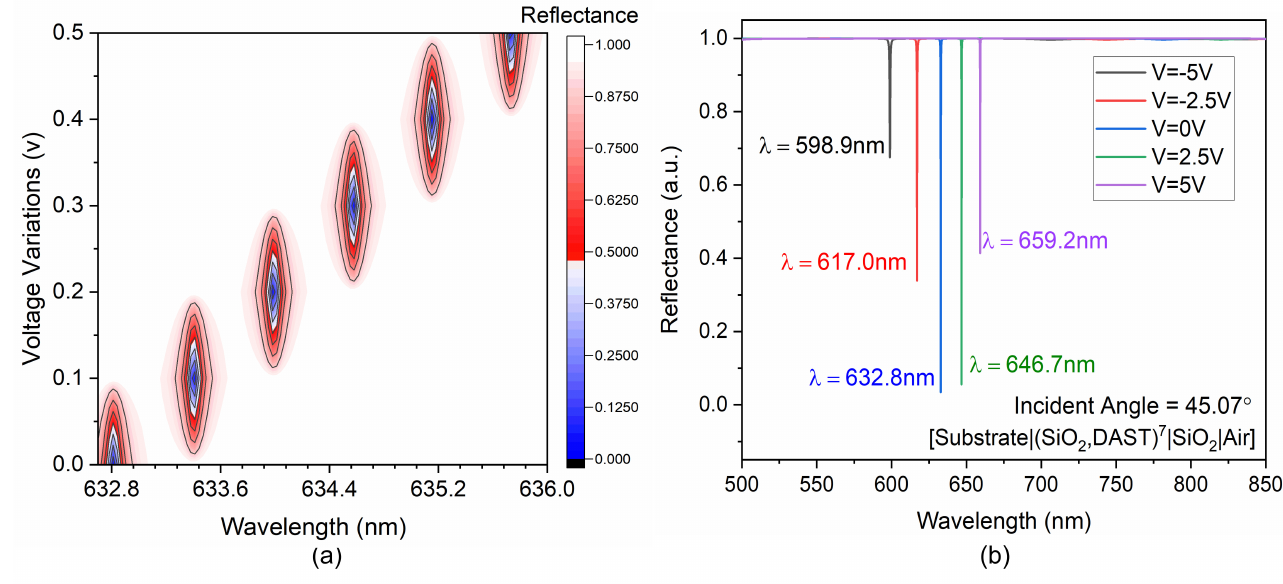
Figure 5. The wavelength-dependent reflectance spectrum at a fixed incidence angle of 45.07 ◦ for applied voltage of: ( a ) 0 V to 0.5 V; ( b ) for − 5.0 V to 5.0